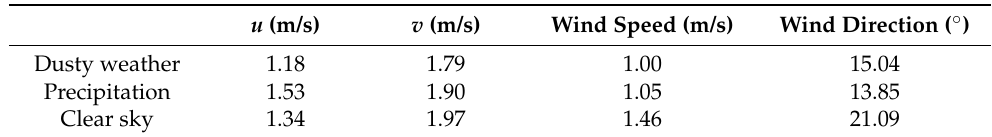
Table 1. The root mean square error (RMSE) of each element observed by CDWL and GTS sounding for different weather types.